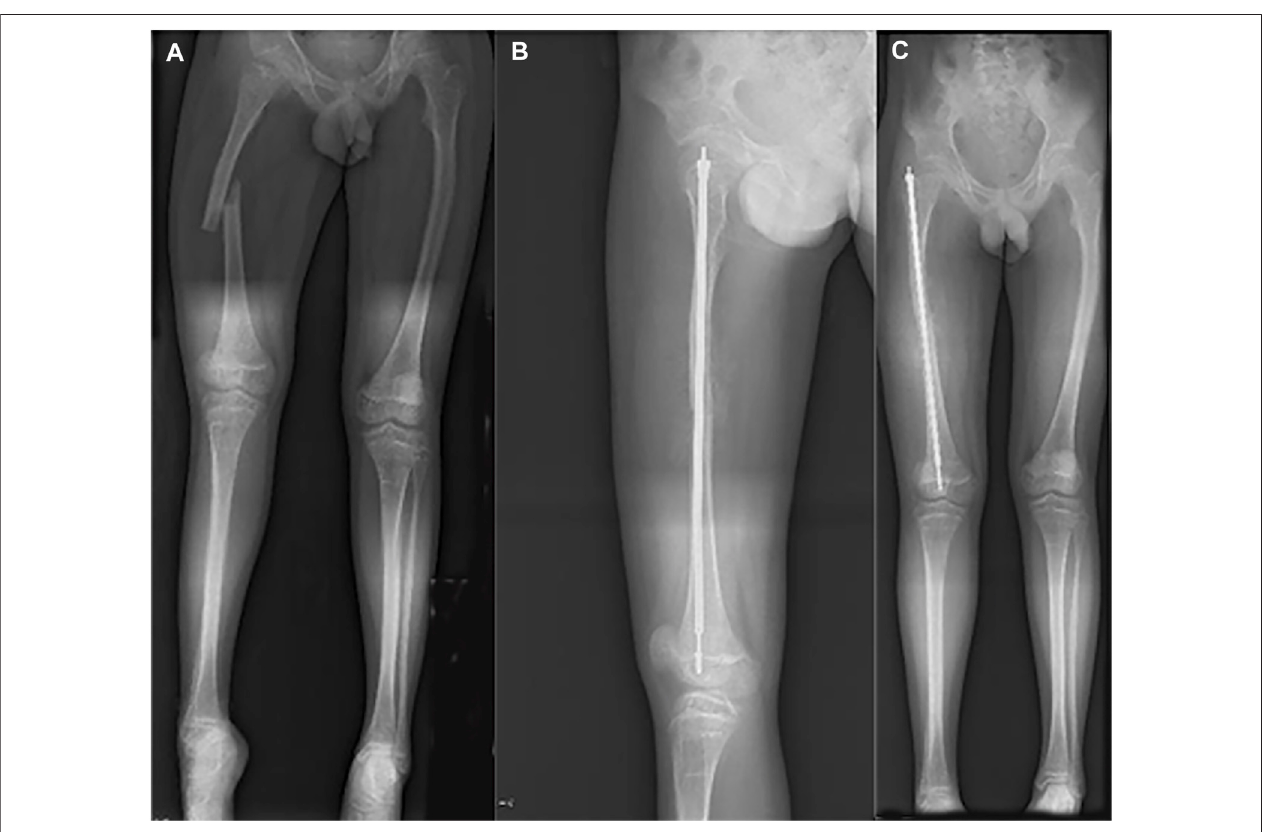
FIGURE 4 | Radiograph of 13-year-old boy with right femoral fracture. (A) Full-length AP view of lower extremity before surgery. (B) Lateral of femur after surgery. (C) Full-length AP view of lower extremity after surgery.